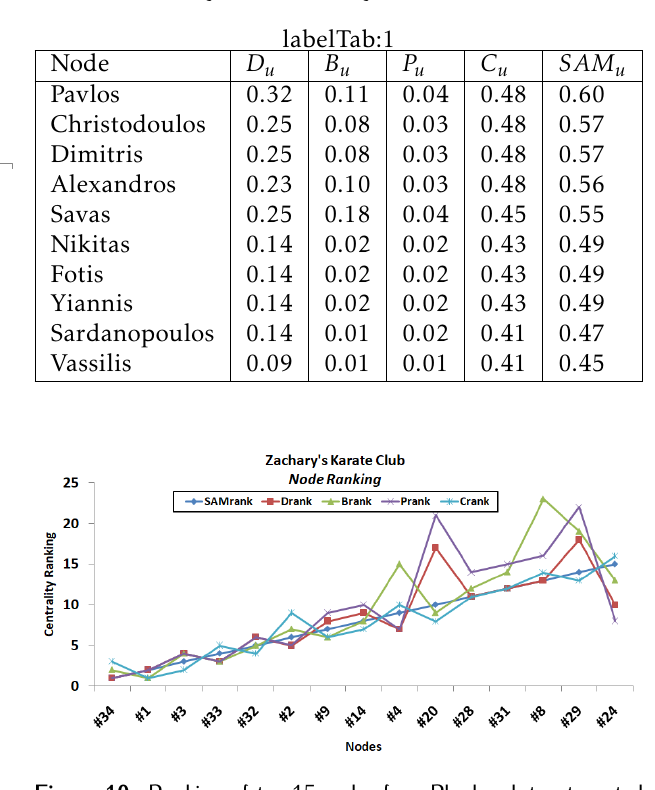
Figure 10. Ranking of top 15 nodes from Rhodes dataset, sorted by SAM centrality